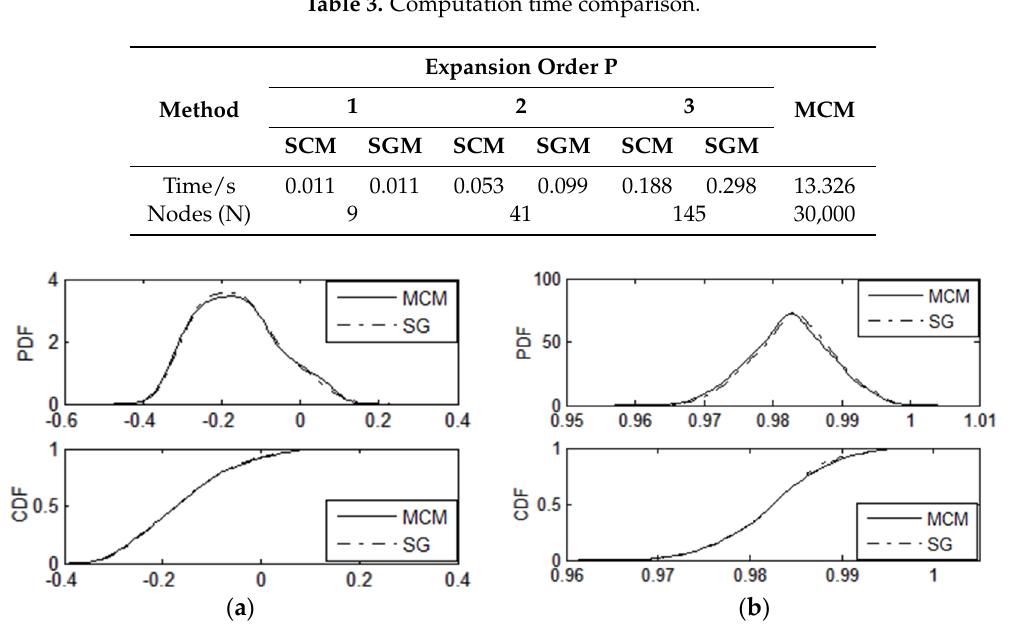
Figure 7. PDFs and CDFs of θ , V at the bus which has large fluctuation: ( a ) θ 14 (rad); ( b ) V 4 (p.u.). Table 3. Computation time comparison.